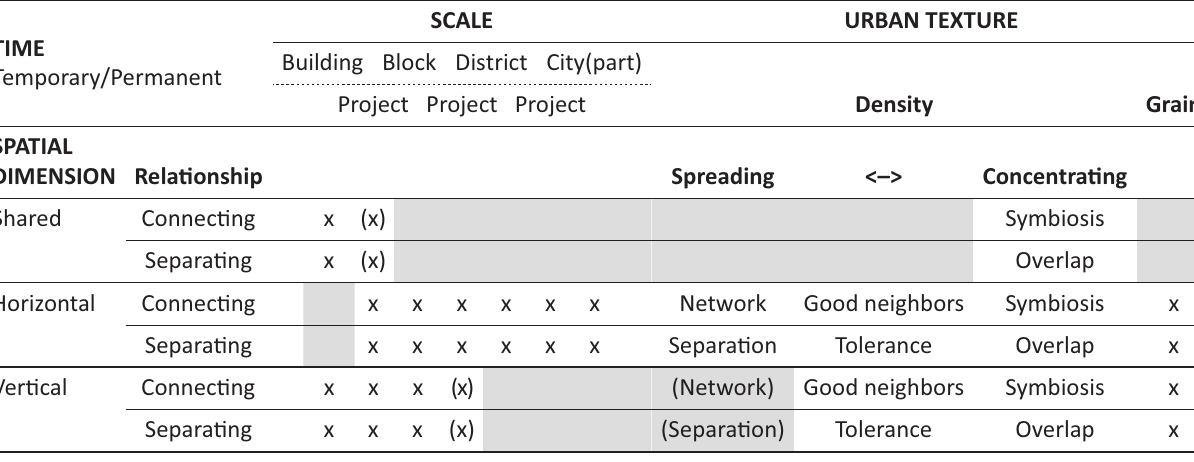
Table 2. Analytical scheme of mixed‐use, based on Hoppenbrouwer and Louw (2005) and Leinfelder and Pisman (2008).